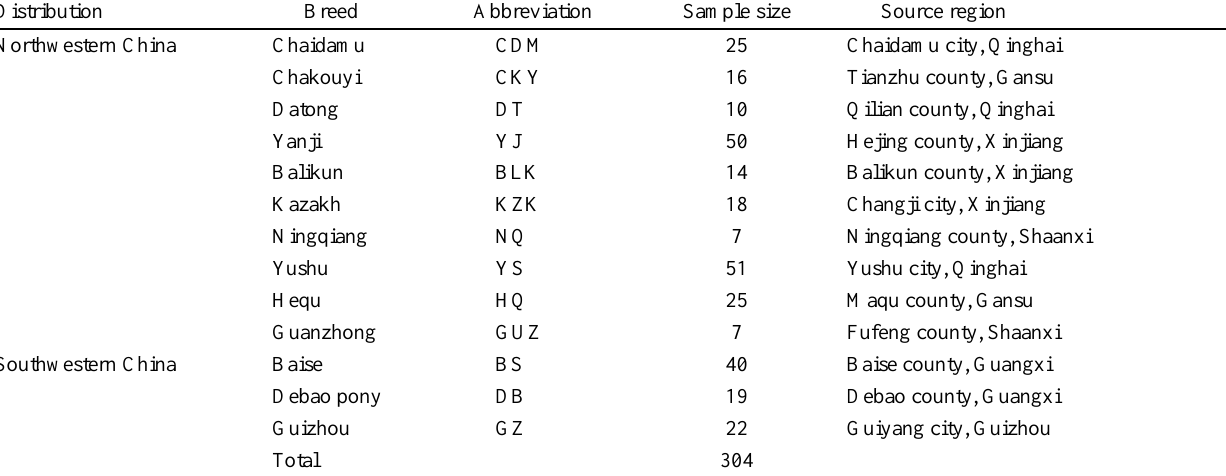
Table 1. Sample information of 13 horse breeds in China Distribution Breed Abbreviation Sample